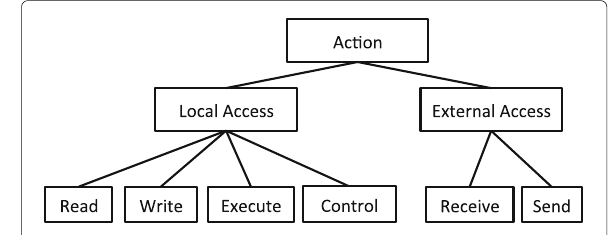
Fig. 2 Hierarchy of criteria for class Applications